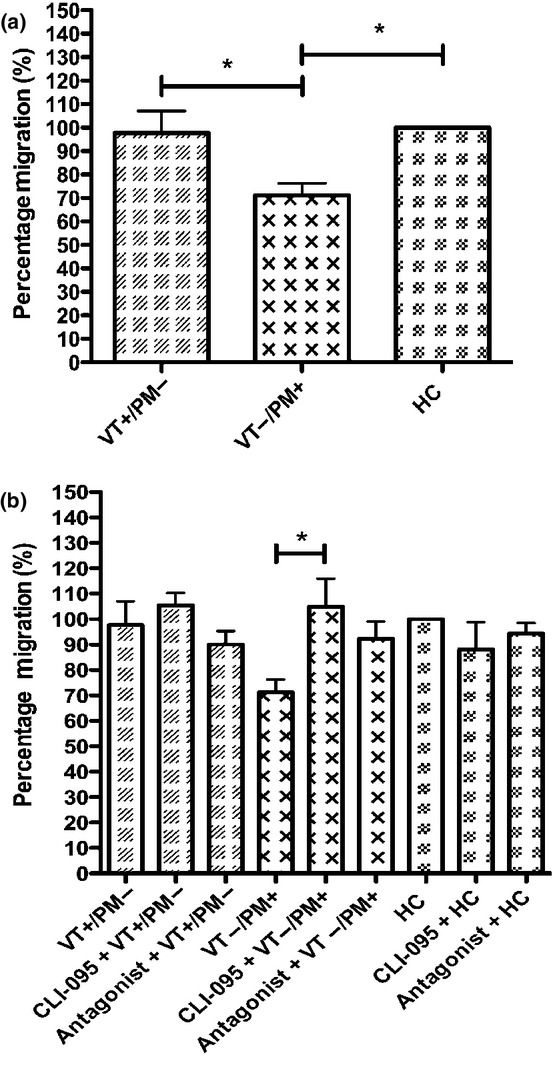
IgG purified from patients with VT−/PM+ APS inhibit HTR-8 cell invasion, which is abrogated when cells are treated with a TLR4 inhibitor. The ability of HTR-8 cells to invade after treatment with 100 μg/mL pooled IgG from VT+/PM− with 83.7 GPLU and 66.0SU binding activity, VT−/PM+ with 47.2GPLU and 63.8SU binding activity and HCs with 0GPLU and SU binding (a) and following pre-treatment with the TLR4 inhibitor CLI-095 or TLR4 antagonist, Ultra Pure Rhodobacter sphaeroides LPS (b) was measured using a transwell invasion assay after 48 hr. HC cell invasion was set at 100%, and the relative invasion of HTR-8 cells exposed to APS-IgG was analysed from this. Graph shows mean ± SEM of quantitative analysis from six (a) and three (b) independent experiments. Statistical analysis was performed as follows: (a) one-way anova (P = 0.01) with Dunn's multiple comparisons test (*P < 0.05); (b) one-way anova (P = 0.03) with Dunn's multiple comparisons test (*P < 0.05).